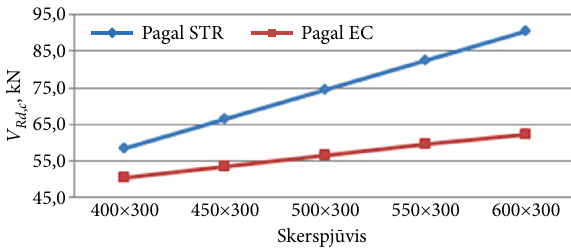
4 pav. pateiktame grafike pastebimas nežymus įs- trižojo pjūvio stiprumo didėjimas, didėjant tempiamo-